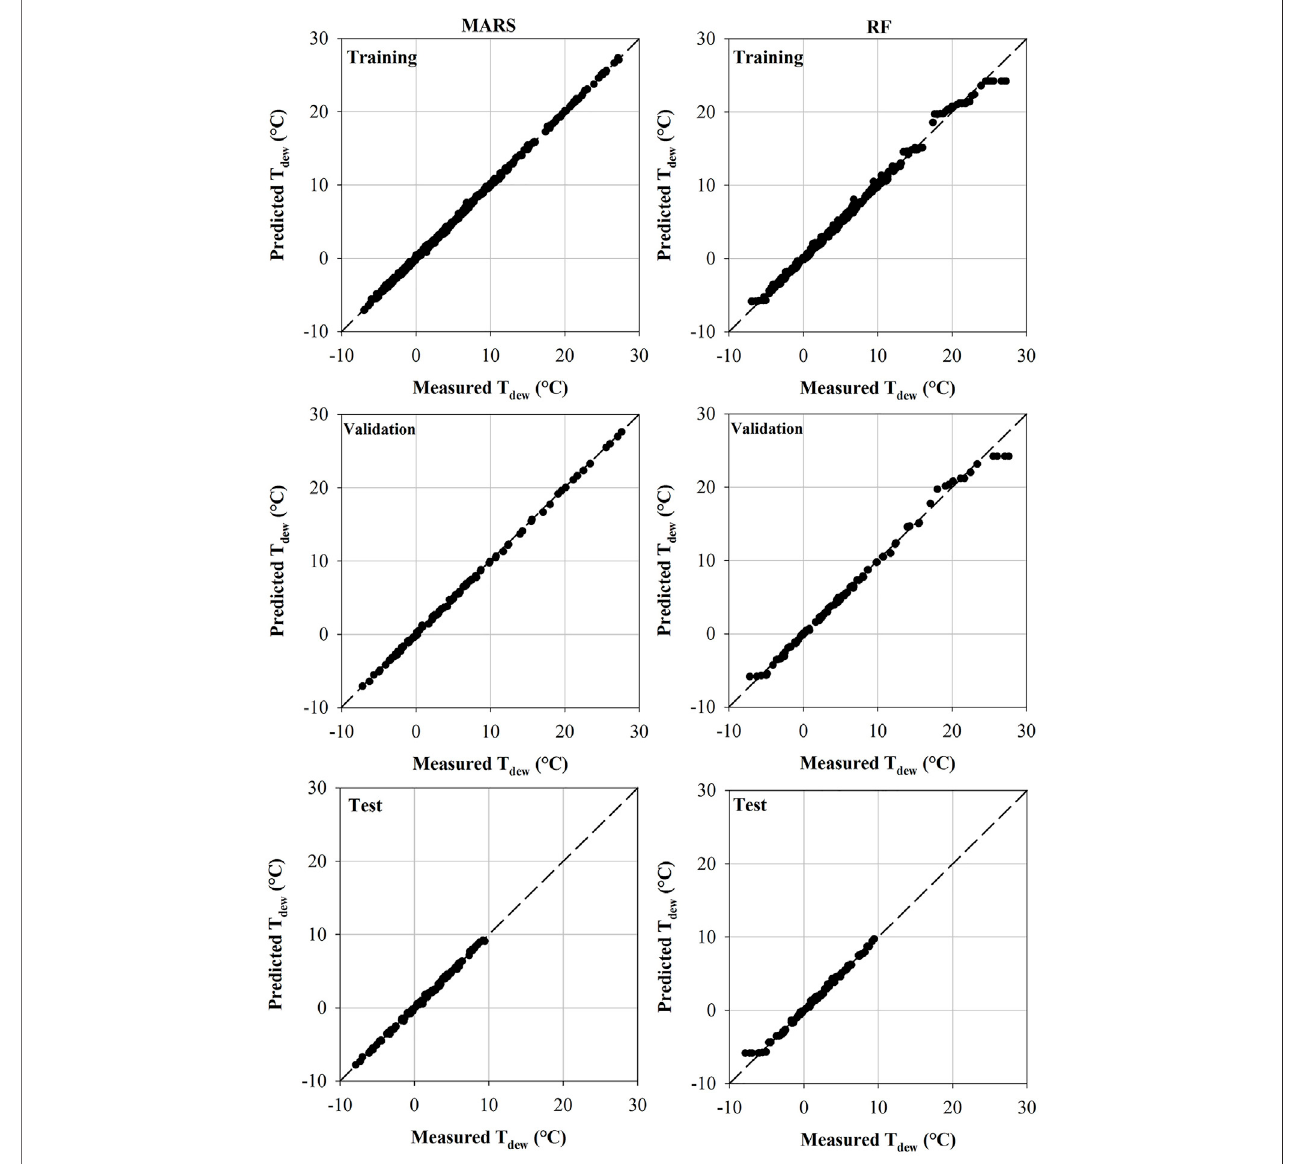
FIGURE3| Dewpointtemperature (T dew )predictedbythesuperiorscenarios ofRFandMARSapproaches versusthemeasuredvaluesforthetraining,validation, and test phases.